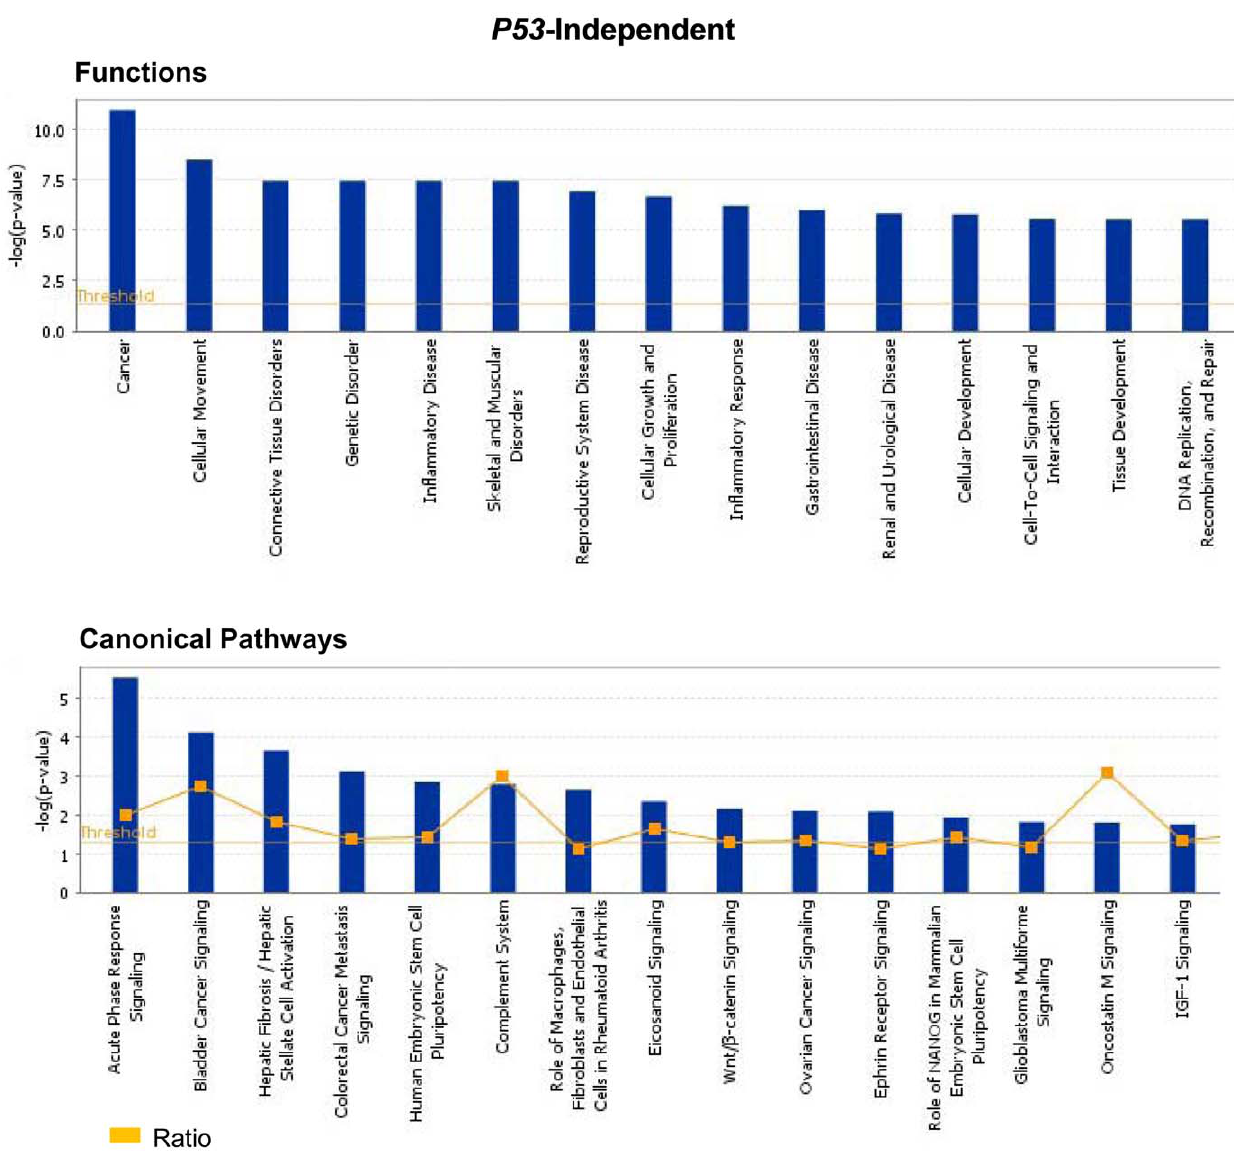
Figure 6. Ingenuity Pathway Analysis (Ingenuity Systems, Inc) of the genes that were regulated by Mta1 in the absence of P53 was performed. Fisher’s exact test was used and threshold of 0.05 was set as the cutoff. Top 15 functions associated with the genes and the top 15 canonical pathways in which these genes might have a role are shown.